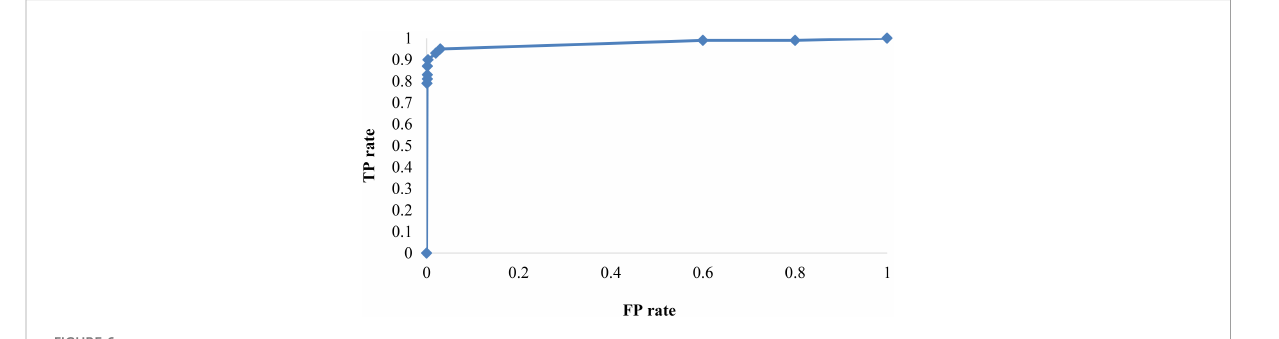
FIGURE 6 Performance evaluation of the proposed hybrid model using ROC